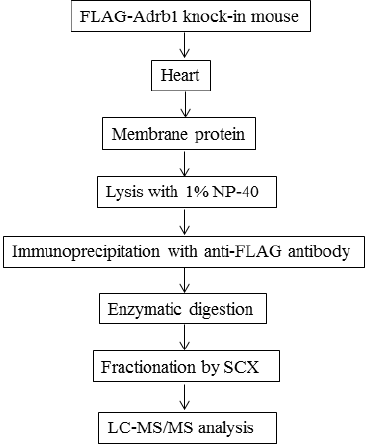
Figure 3. Flowchart describing the sequential steps for identifying β 1AR-derived tryptic peptides in FLAG-Adrb1 knock-in (KI) mice. Membrane protein lysate prepared from the FLAG-Adrb1 KI mouse heart was immunoprecipitated with the anti-FLAG antibody. Immunoprecipitates were digested enzymatically and subjected to strong cation exchange (SCX) fractionation and LC–MS/MS analysis.